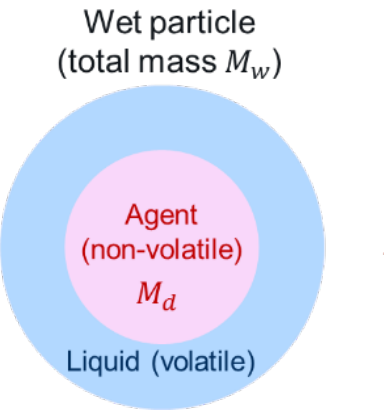
Figure A1. Visualization of the particle generation submodel workflow. Due to the rapid time scale at which it occurs (i.e., within the first 50 s), near-field dynamics of the Particle Transport submodel (Evaporation box in green) is displayed alongside the Particle Generation submodel. Red circles indicate parameters selected for sensitivity analysis (see Section 2). All notation definitions are provided in Table 1.